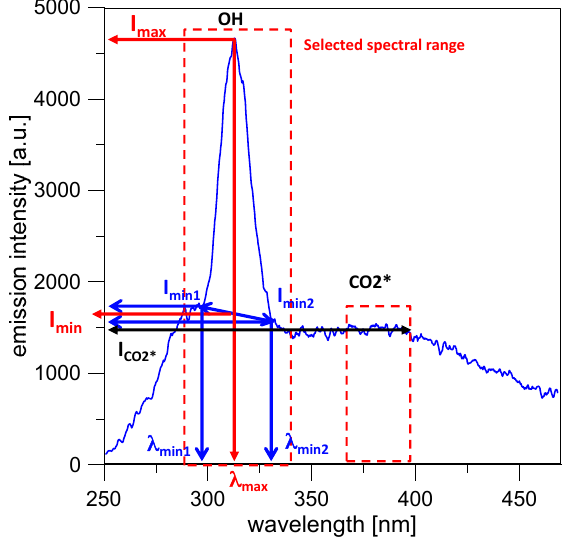
Figure 2. Schematization of the applied methodology for retrieving the emission intensity of chemical species from spectroscopic results.